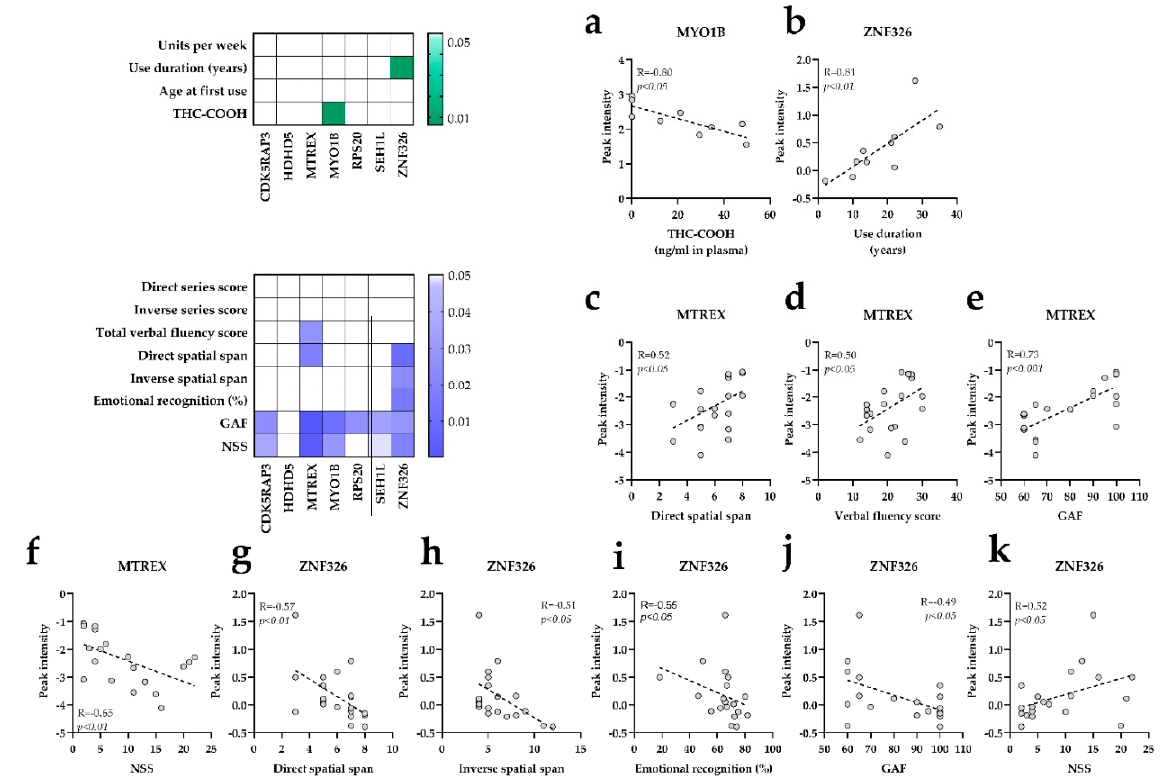
Figure 4. Association studies of protein markers, cannabis use and neurocognitive performance. ( a ) THC-COOH (ng/mL plasma) and MYO1B correlation. ( b ) Use duration and ZNF326 spearman correlation. ( c ) MTREX and direct spatial span correlation. ( d ) MTREX and verbal fluency score correlation. ( e ) MTREX and GAF correlation. ( f ) MTREX and NSS correlation. ( g ) ZNF326 and direct spatial span correlation. ( h ) ZNF326 and inverse spatial span correlation. ( i ) ZNF326 and emotional recognition correlation. ( j ) ZNF326 and GAF correlation. ( k ) ZNF326 and NSS correlation. In the correlation matrixes, only the significant correlations are colored. Darker squares indicate lower p-values.